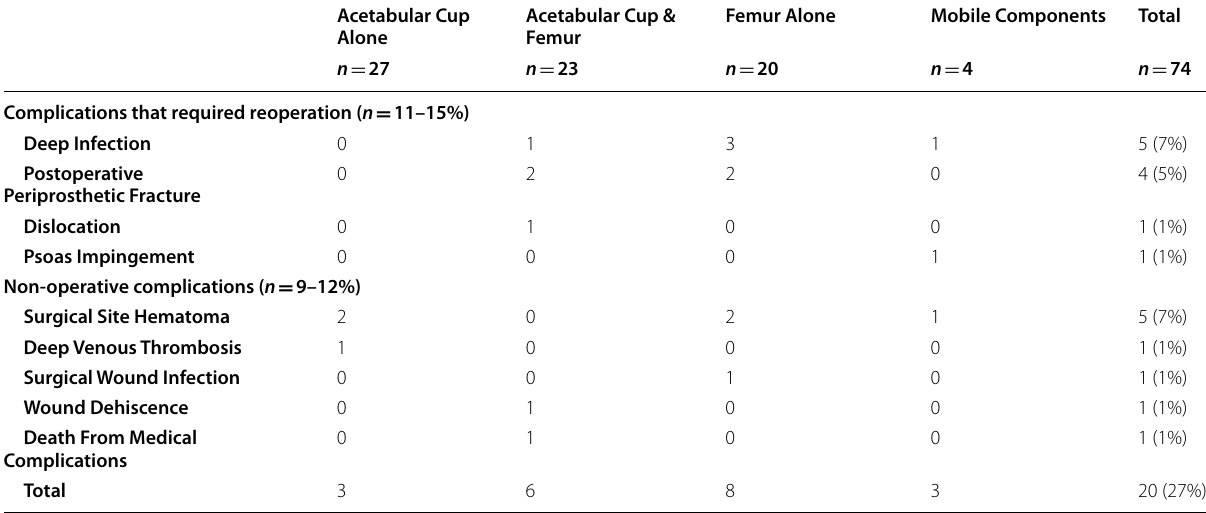
Table 3 Summary of